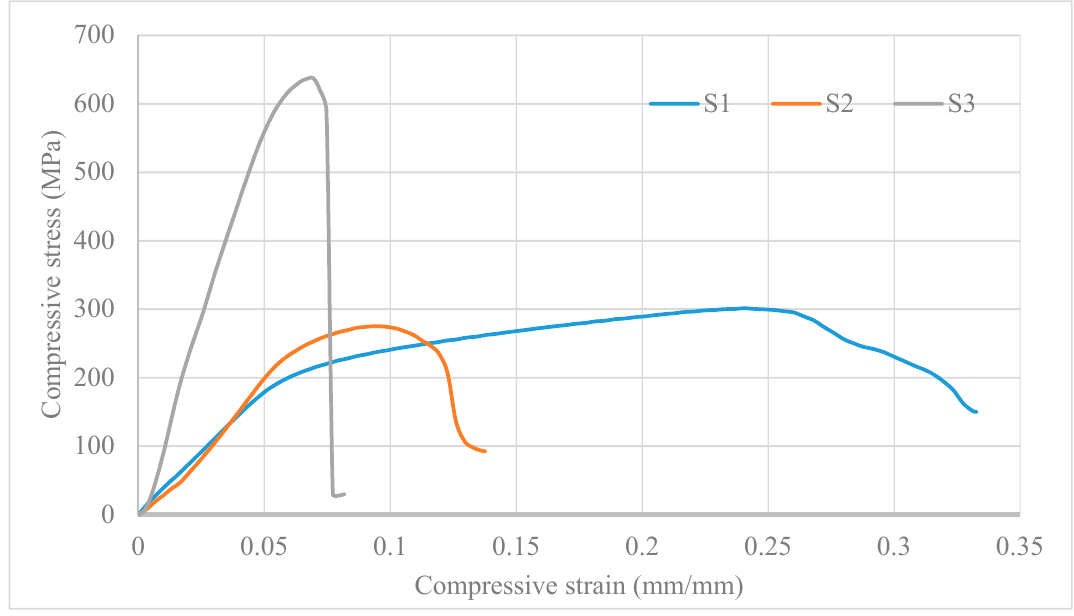
Figure 11. stress-strain uniaxial compression curves.